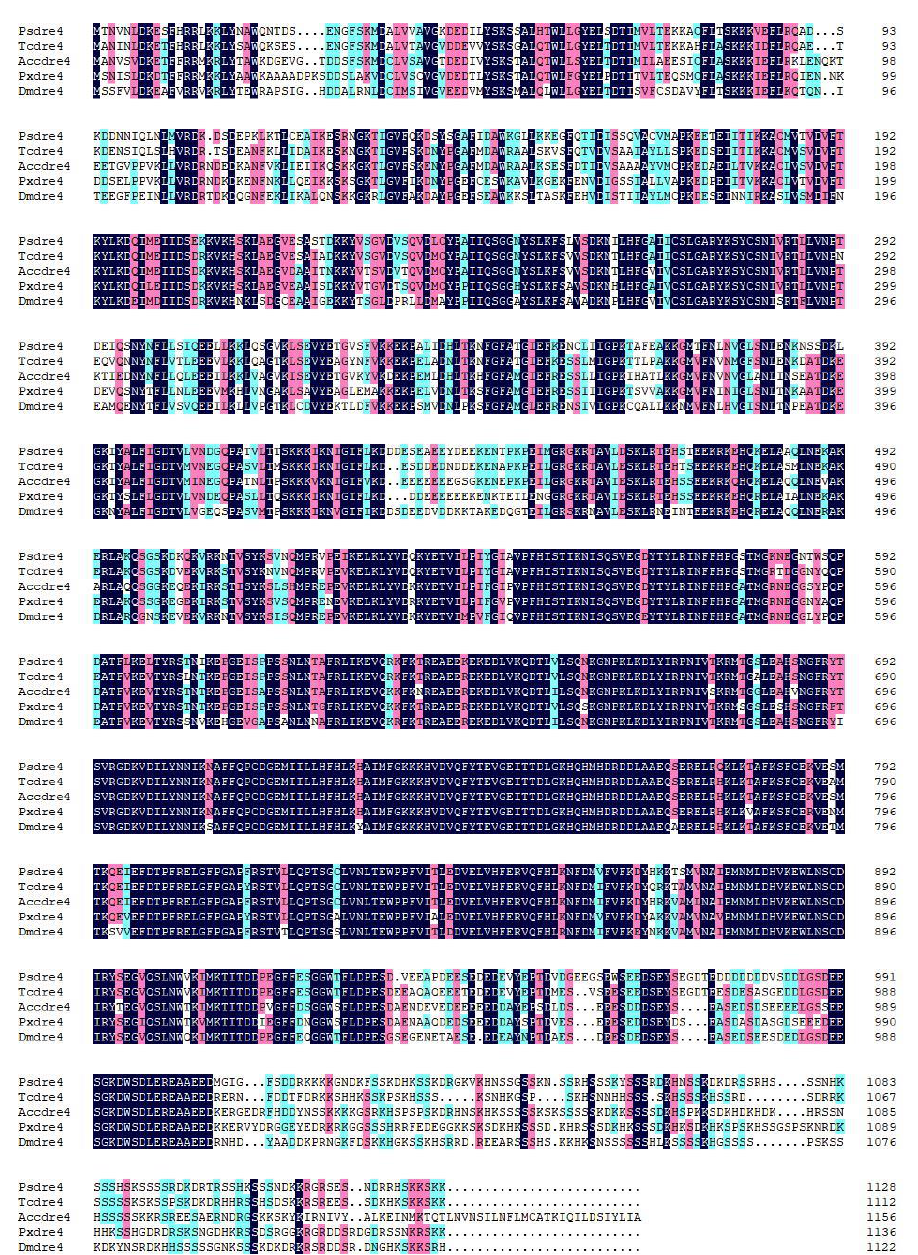
Figure 2. Multiple sequence alignments showing the sequence similarities between Psdre4 and Pxdre4 ( Plutella xylostella , KAG7307081.1), Dmdre4 ( Drosophila melanogaster , NP_476610.2), Tcdre4 ( Tribolium castaneum , EFA04061.1), and Acdre4 ( Apis cerana , PBC33546.1).